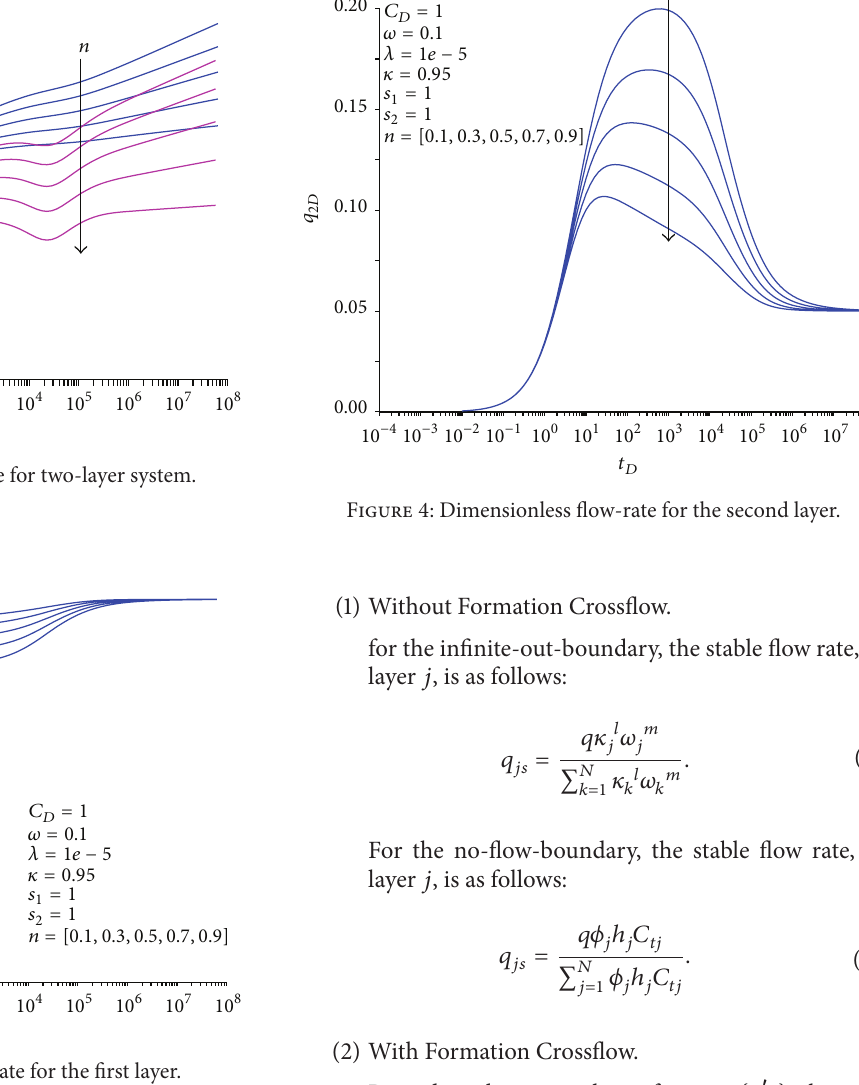
Figure 3: Dimensionless flow-rate for the first layer.